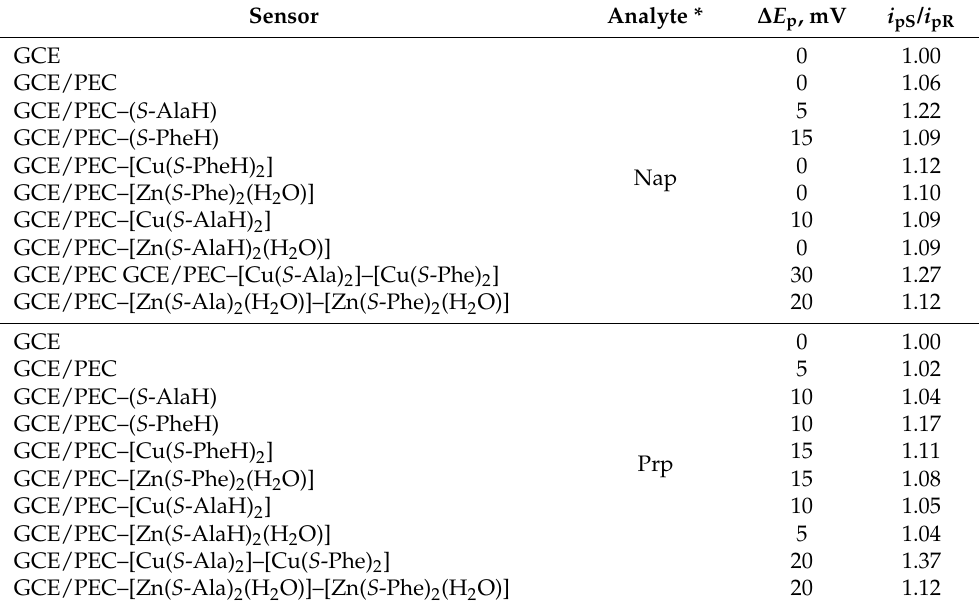
Table 2. Comparison of the enantioselectivity of unmodified and modified sensors based on a GCE. Sensor Analyte